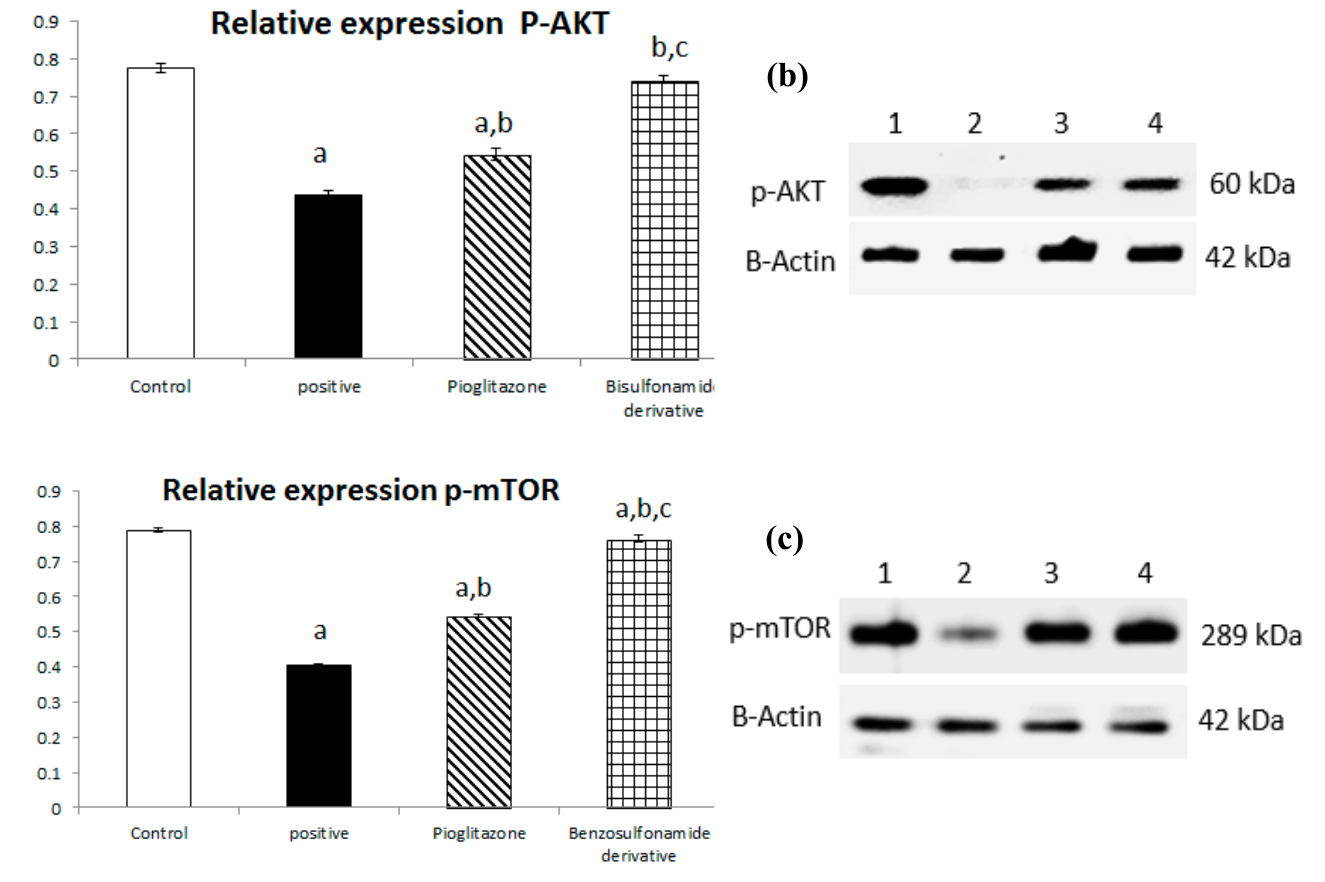
Figure 6. Bar chart presentation of the liver protein relative expression of p-PI3K/p-AKT/p-mTOR figure subdivided into ( a ) represents p-PI3K, ( b ) represents p-AKT and ( c ) represents p-mTOR concerning the effect of 14 days of oral administration of the synthetic compound against the refer- ence anti-hyperglycemic pioglitazone on STZ-induced type 2 DM. DM: diabetes mellitus. Each bar represents the mean of 6–8 values ± the standard error of the mean (S.E.M). a: Significantly different from the normal control group, b: Significantly different from the positive control group, c: Signifi- cantly different from the pioglitazone group at p < 0.05.